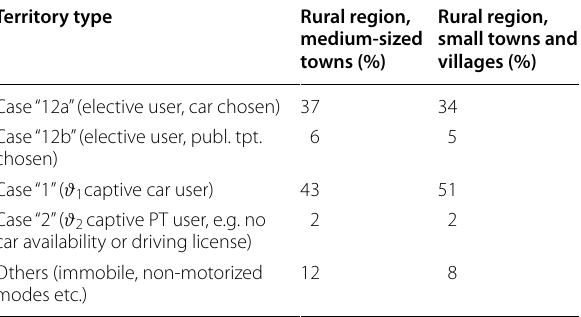
Table 3 Initial situation of trip modal split, all individuals—own analysis based on DLR